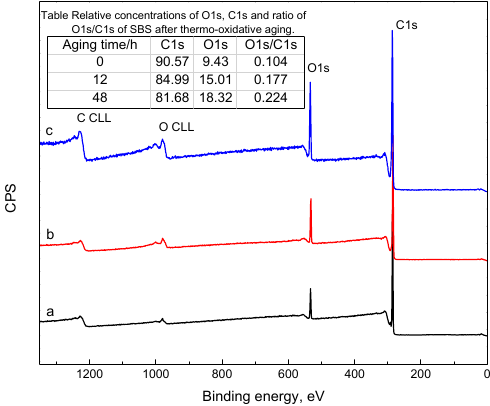
Figure 3. XPS survey spectra of ( a ) neat SBS; ( b ) aged SBS exposure at 150 °C for 12 h with an oxygen flowrate of 1 L/min; ( c ) aged SBS exposure at 150 °C for 48 h with an oxygen flowrate of 1 L/min.